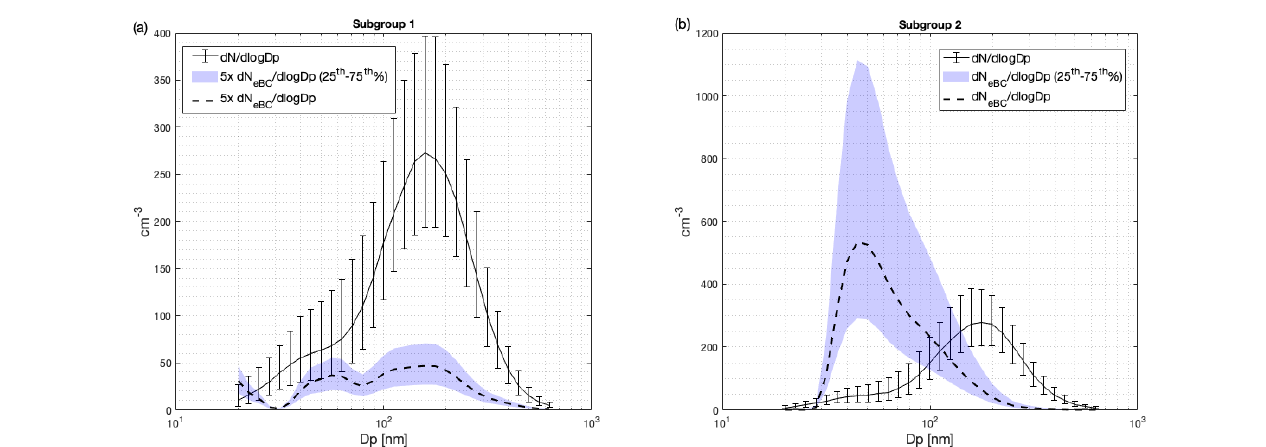
Figure 2. Comparison between observed particle size distributions (black solid) and inferred dN eBC /dlogD p (black dashed) distributions assuming external mixtures for Subgroup 1 ( a ) and Subgroup 2 ( b ). For Subgroup 1, the inferred dN eBC /dlogD p is multiplied with the factor 5 to show the distribution shape more clearly. The blue shaded area and error bars represents the lower and upper quartiles of the